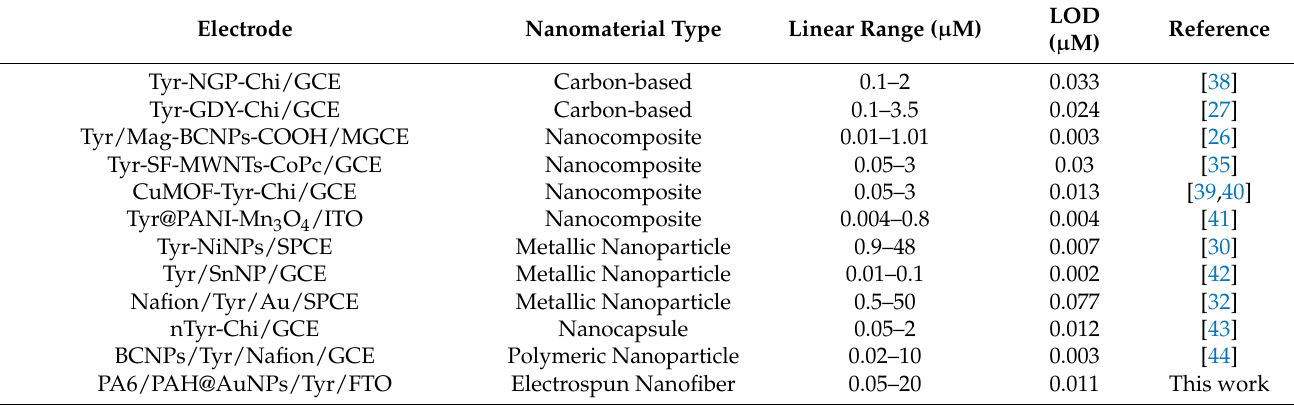
Table 1. Comparison of nanomaterial-based tyrosinase electrochemical biosensors for BPA detection. Electrode